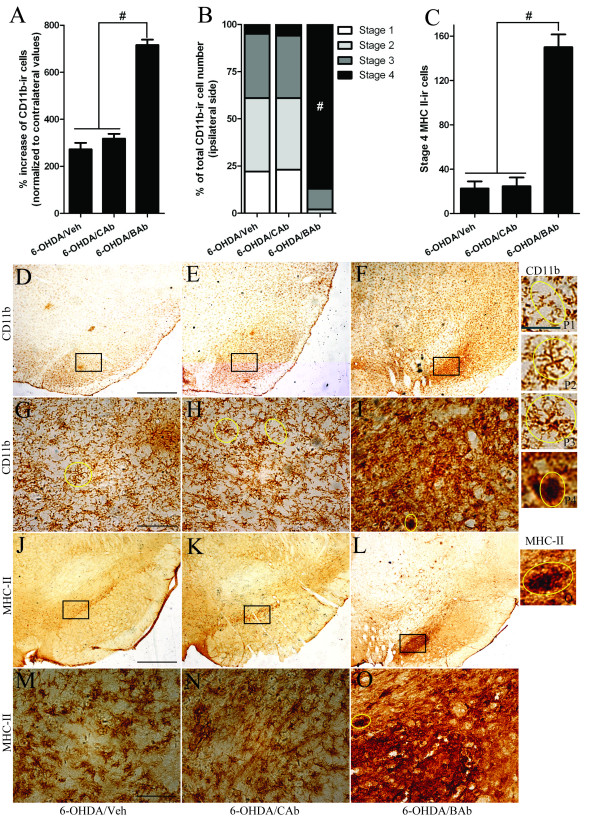
Effects of BAb on microglial morphology and cell number in SN. Representative sections of SN in different groups were immunostained with antibodies against CD11b (a microglia marker) (D-I) and MHC II (a marker for activated microglia) (J-O) 21 days after 6-OHDA-injection. G-I and M-O are higher magnifications of the fields outlined by rectangles in D-F and J-L respectively. Scale bar: 500 μm in D-F and J-L; scale bar: 50 μm in G-I and M-O. Representative microglia in different stages (stage1-4) of CD11b immunostaining are shown in yellow circles (stage1: P1; stage2: P2; stage3: P3; stage4: P4), and a representative of stage 4 MHC II-ir microglia is shown in panel Q. Scale bar:10 μm in P1-P4 and Q. Microglia cell numbers and morphology were stereologically analyzed in each group. (A) Data represents average increase of CD11b-ir microglia cell number in ipsilateral SN as compared to contralateral SN (n = 5) ± S.E.M. #:P < 0.001. (B) Stereological quantification of each stage of CD11b-ir microglia is depicted as the average percentage distribution per group. # p < 0.001 compared to every other group. (C) Stereological quantification of stage 4 MHC II-ir cells throughout the SN from different experimental groups is shown in bar graph; n = 5, value = mean ± S.E.M. #: P < 0.001 significant difference compared to every other group.